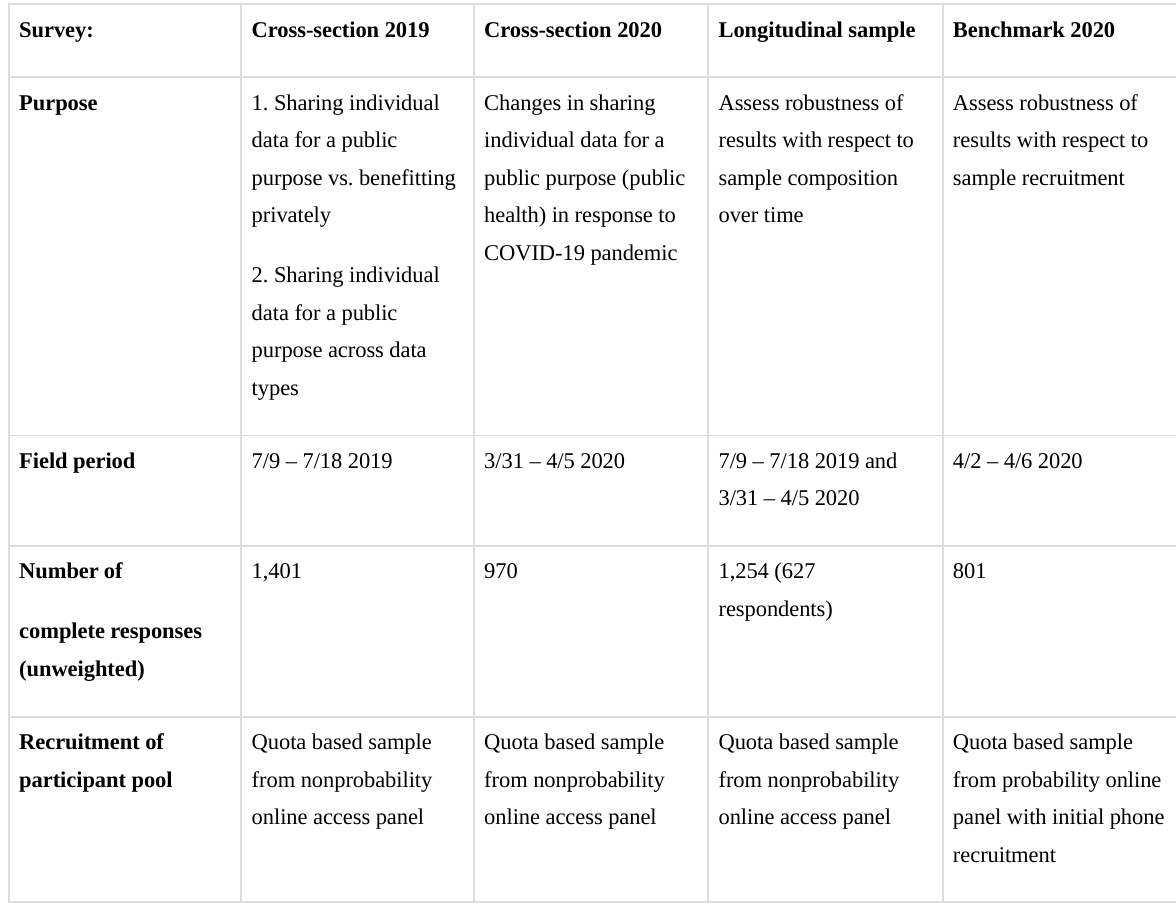
Table 1. Characteristics of the Analysis